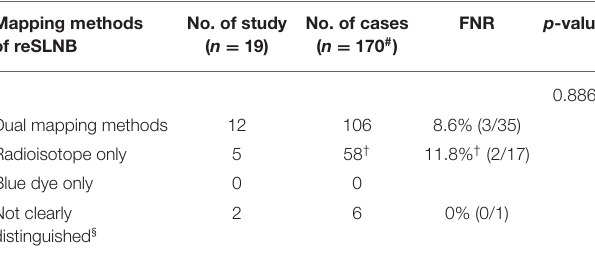
TABLE 3 | False negative rate (FNR) of reSLNB according to mapping